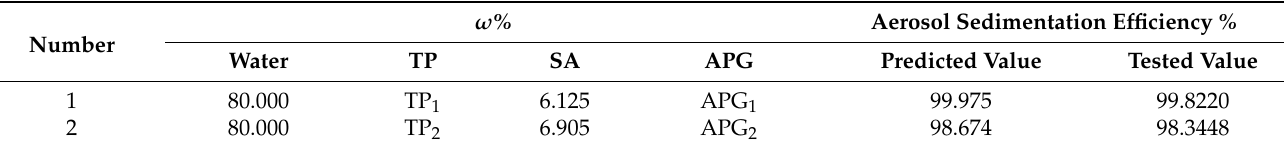
Table 2. The predicted and tested results of the best combination of different ingredients.